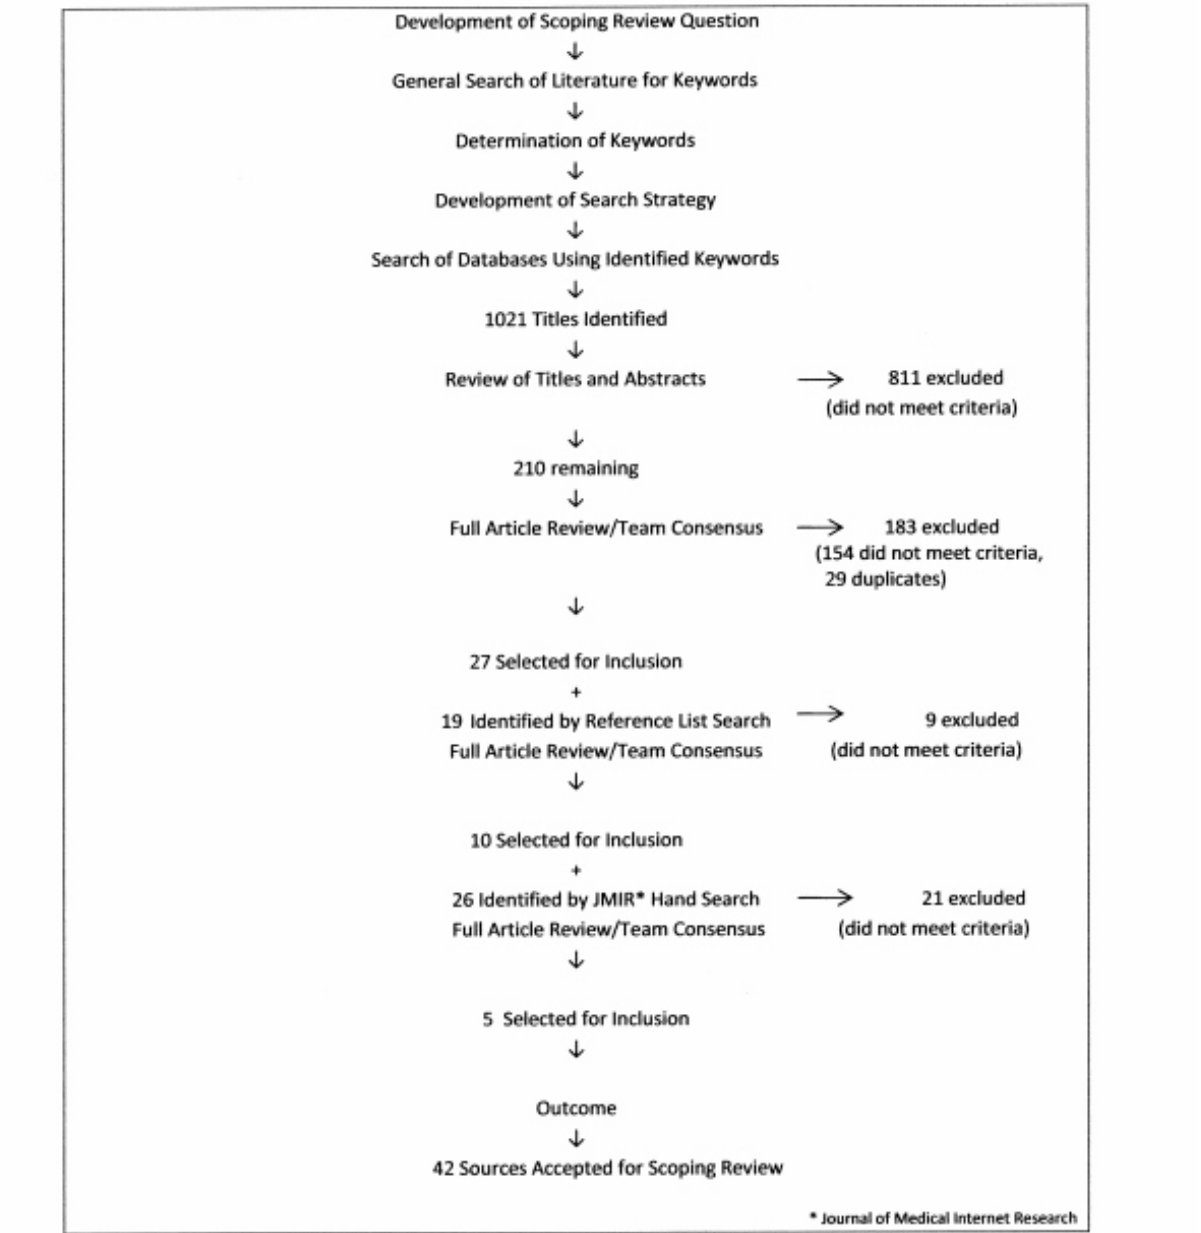
Figure 1. Search strategy and